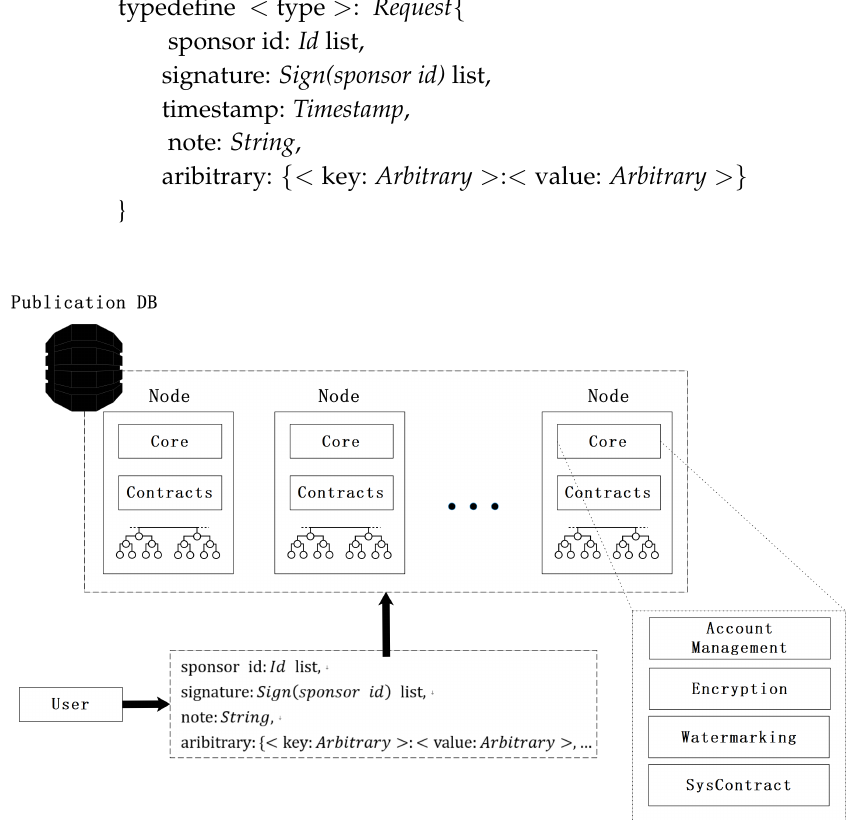
Figure 3. System architecture of Y-DWMS.